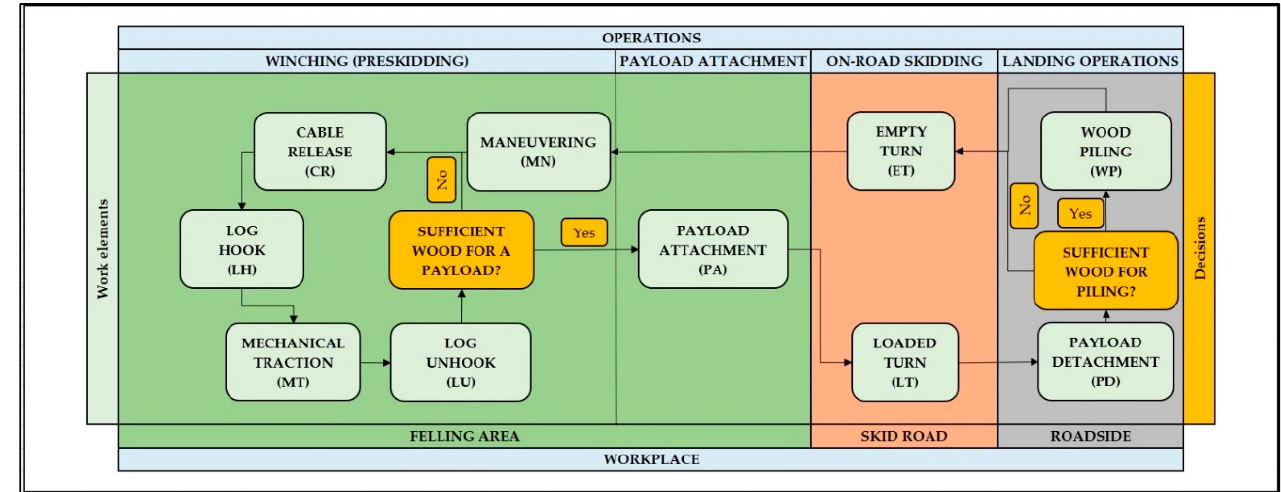
Figure 2. Process flow diagram describing the operations, work elements and workplaces as ob- served in this